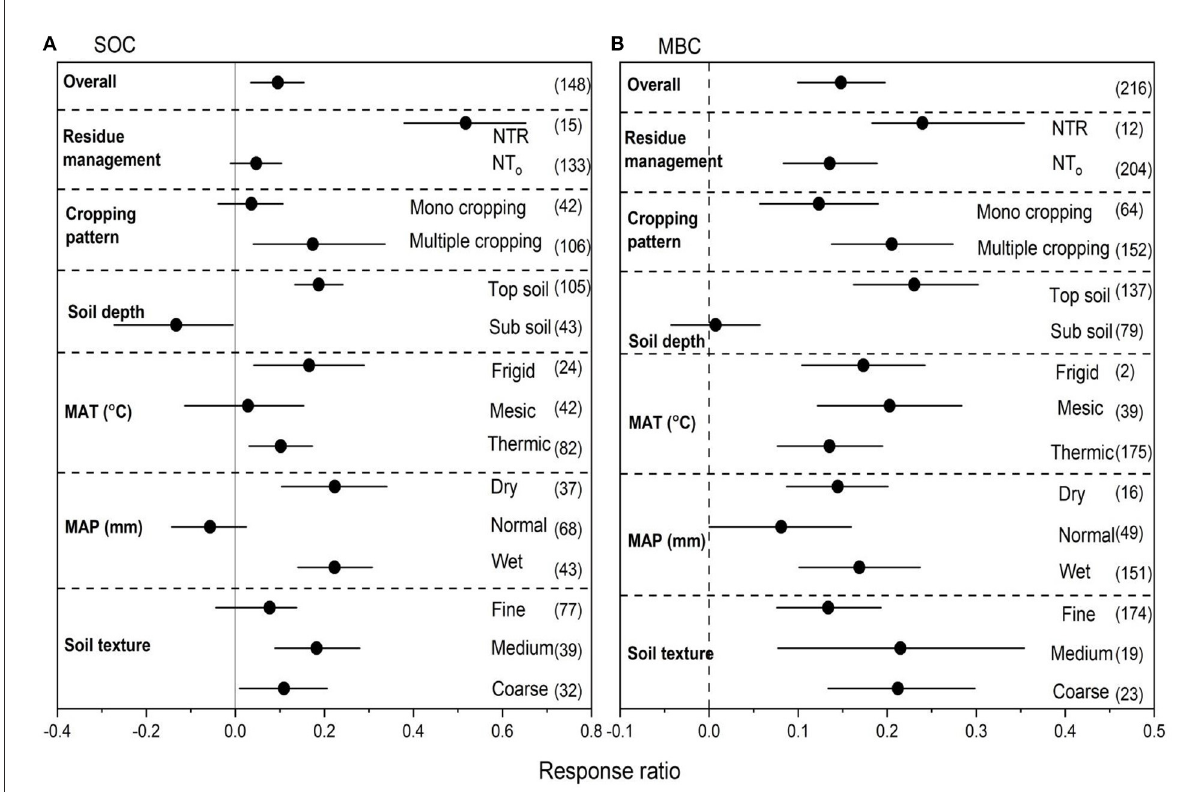
FIGURE3 (A,B) The effect size of soil organic carbon (SOC) and microbial biomass carbon (MBC) with NT compared to CT. If 95% confidence intervals (CIs) do not overlap with zero, there is a substantial difference in the effect size between treatments. Error bars display CIs. The sample size for each variable is displayed next to each bar. The acronyms stand for mean annual temperature (MAT), mean annual precipitation (MAP), retention of residue (NTR), and no residue retention